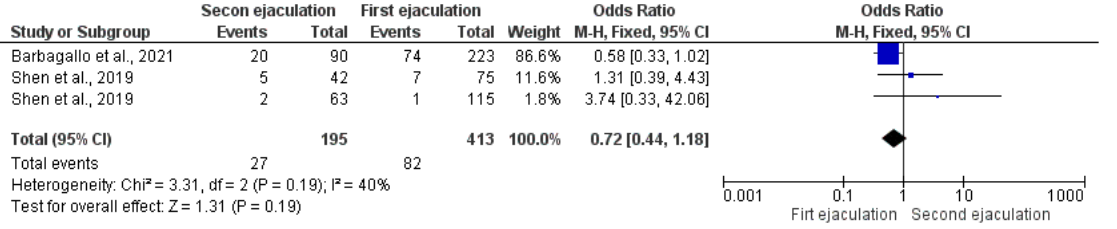
Figure 6. Forest plot of studies showing the effects of a very short abstinence period on the miscarriage rate [29,32].